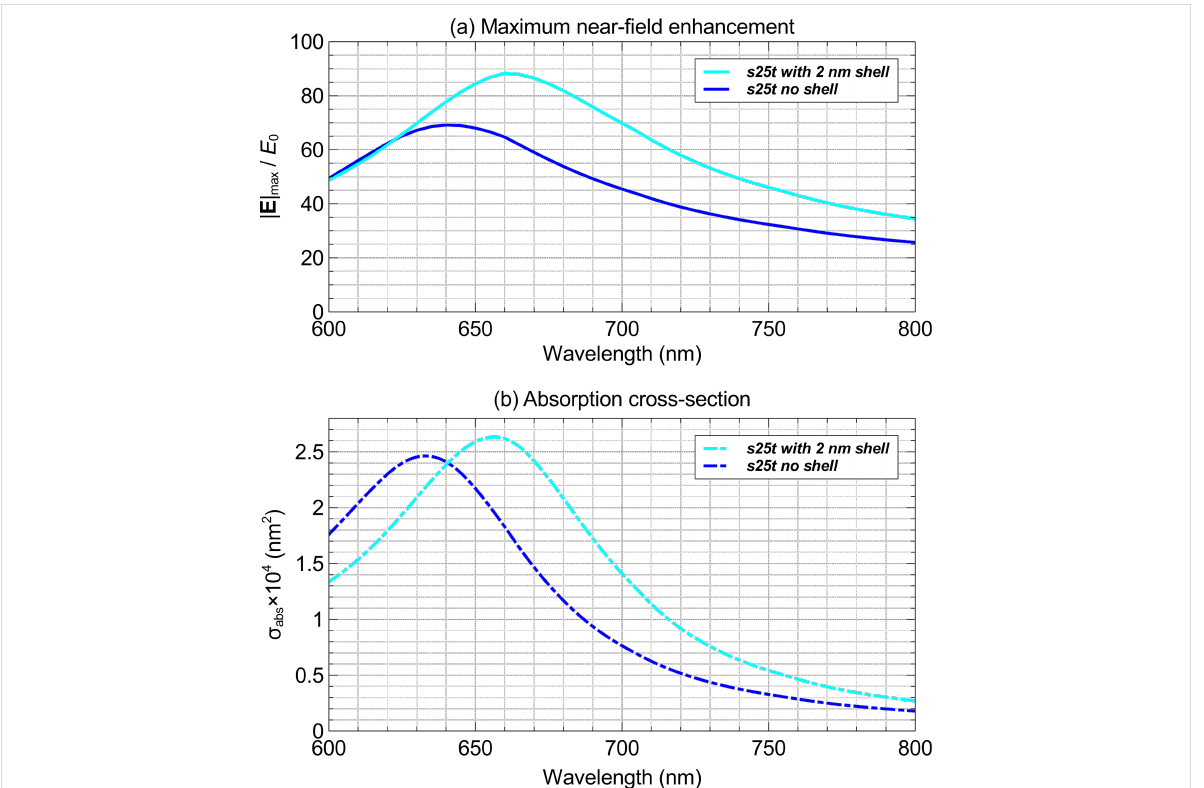
Figure 2: Maximum near-field enhancement, | E | max / E 0 , and absorption cross-section, σ abs , of a 25 nm gold nanosphere trimer with and without inclu- sion of 2 nm thick shell with a refractive index of 1.6.